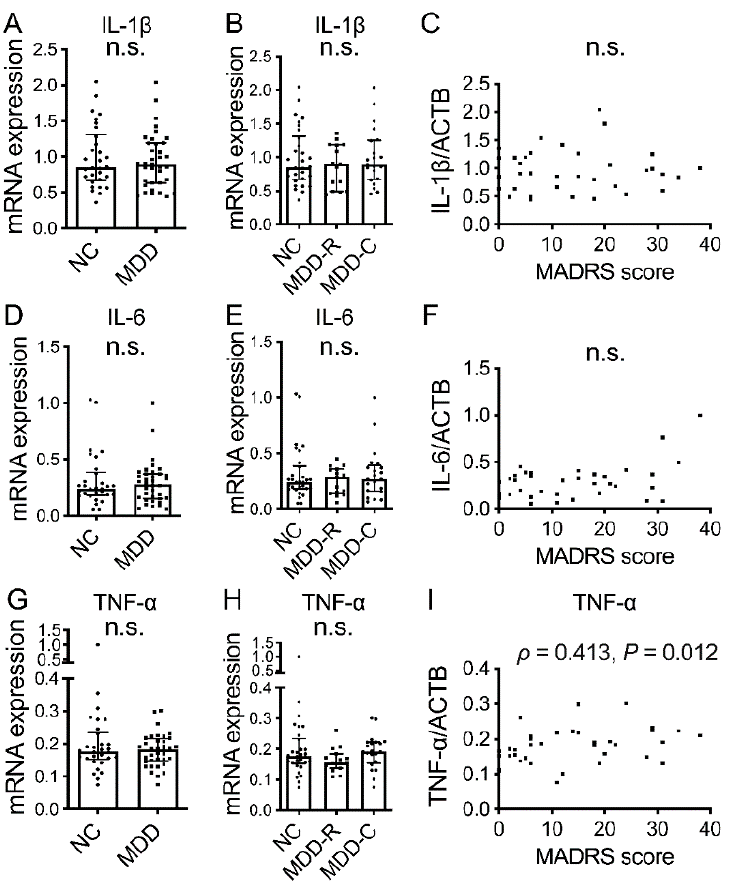
Table 1. Characteristics of participants.